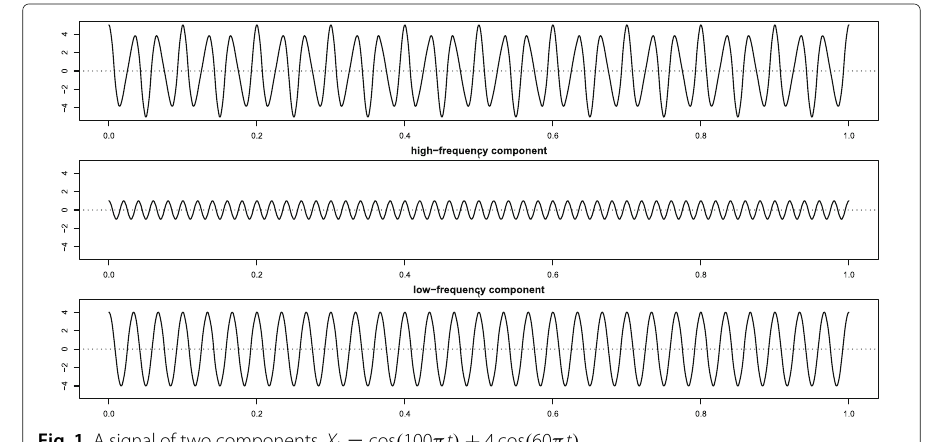
Fig. 1 A signal of two components, X t = cos ( 100 π t ) + 4cos ( 60 π t )